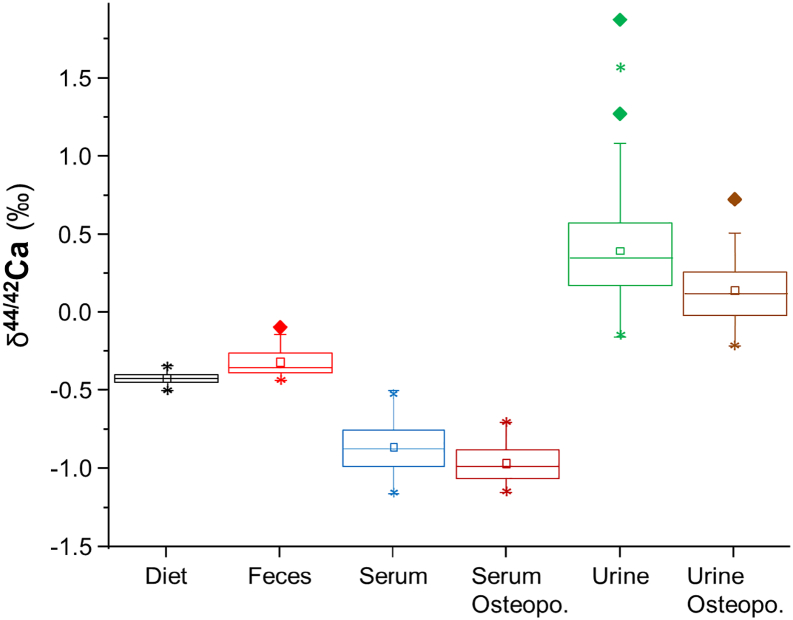
Ca isotope box plot values in women with (n = 14) and without osteoporosis (n = 66). Calcium isotope values in blood and serum are box plotted with their corresponding mean values diet, feces and calculated mean value for bone (see details in the text). There is no statistical difference in Ca isotope values between the two groups concerning the diet (p = 0.300) or the feces (p = 0.600). However, women suffering from DXA diagnosed osteoporosis showed significantly lower δ44/42CaBlood (p < 0.001) and δ44/42CaUrine (p = 0.004) values than those not suffering from osteoporosis. Boxes mark the 25% and 75% quartile, lines mark the median and squares mark the mean value. Diamonds mark outliers and stars mark the 1% and 99% limit of the data.